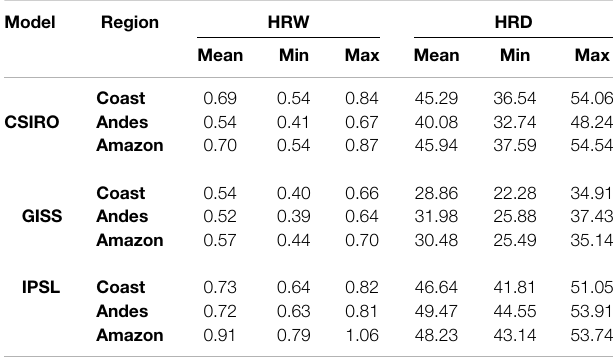
TABLE 6 | Mean of Sen ’ s estimated slope magnitude in each region for HRW and HRD, with a 95% con fi dence interval. Model Region HRW Mean